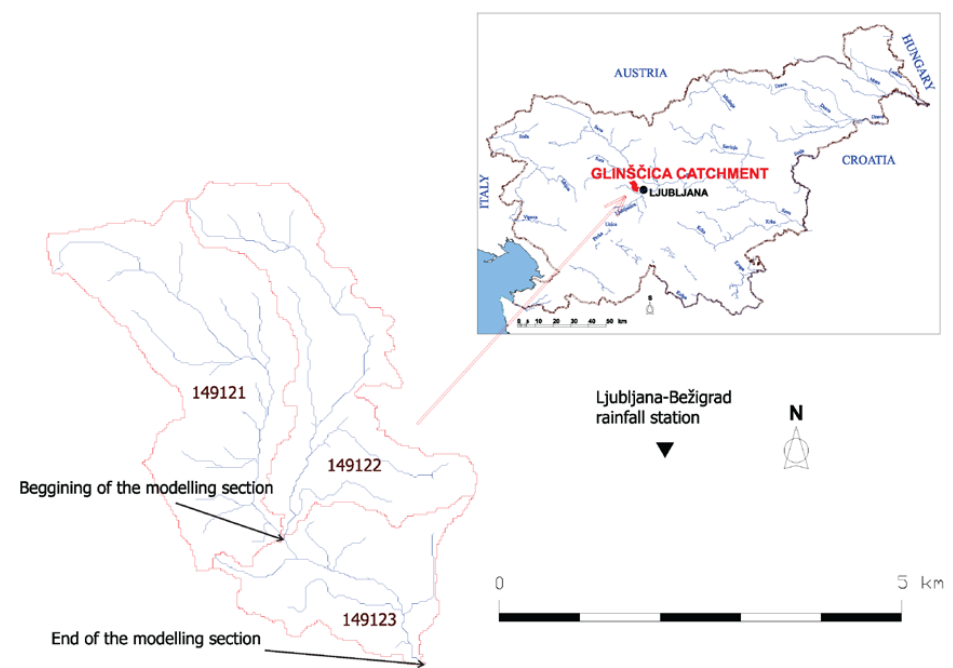
Figure 1. Location of the Glinščica Stream catchment on a map of Slovenia , and the Glinščica River catchment divided into three sub-catchments. The hydraulic modelling was performed in the 149123 sub-catchment from the beginning (confluence of sub-catchments 149121 and 149122) to the end (confluence of the Glinščica Stream and the Gradaščica River) of the river network in this sub -catchment. The official water level and discharge measurements in Slovenia are performed by the Slovenian Environment Agency (ARSO). However, in the Glinščica Stream catchment , there is currently no discharge gauging station (there is about 15 years of data available before 1970, but catchment has significantly changed during the past 50 years [38]; therefore, this data was omitted in this study).